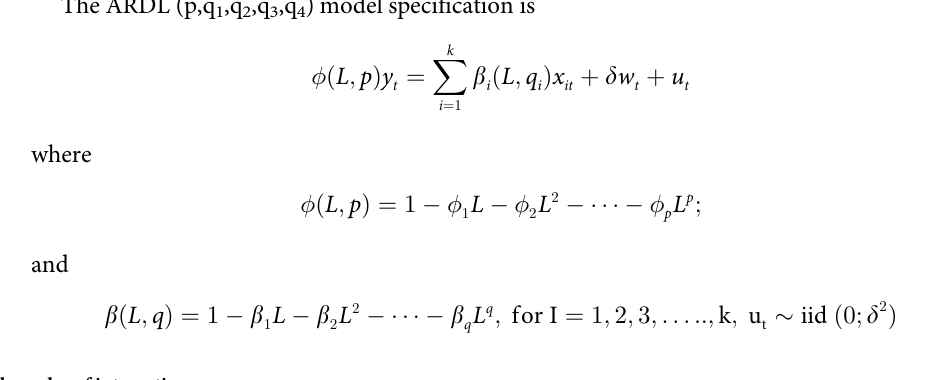
Table 2. Unit root test for variables to assess the order of